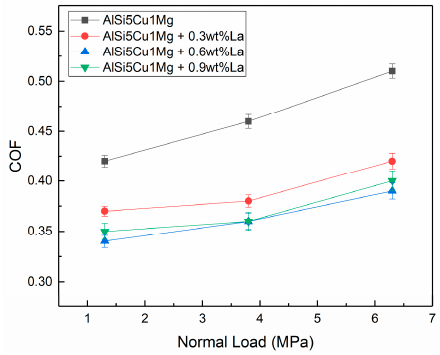
Figure 8. The Coefficient of Friction (COF) of alloys at sliding velocity of 0.19 m/s.